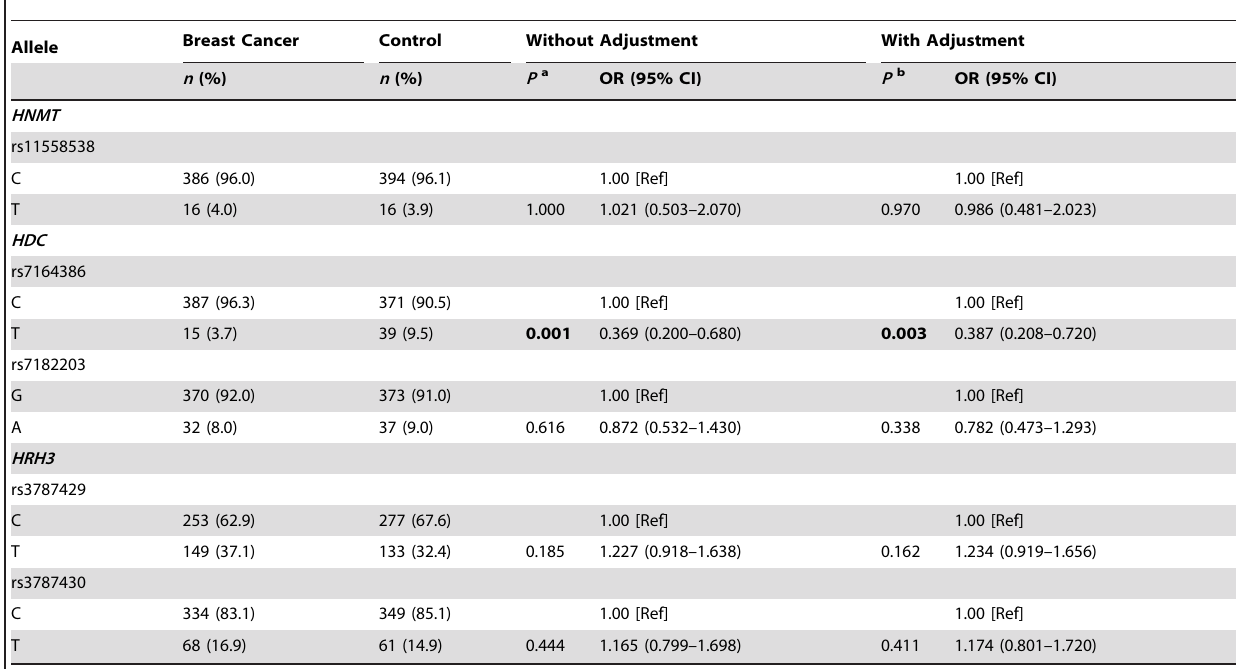
Table 3. Frequency distributions of HNMT , HDC and HRH3 alleles and their associations with the risk of developing breast cancer.